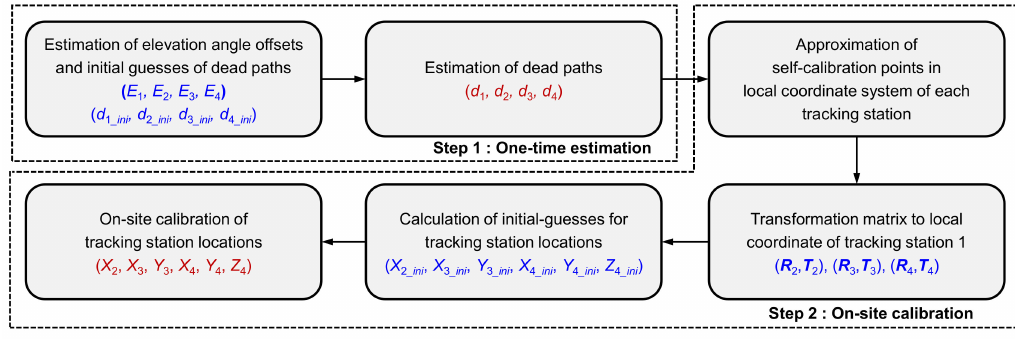
Figure 5. Flow chart of the proposed self-calibration method for an absolute distance measurement (ADM)-based